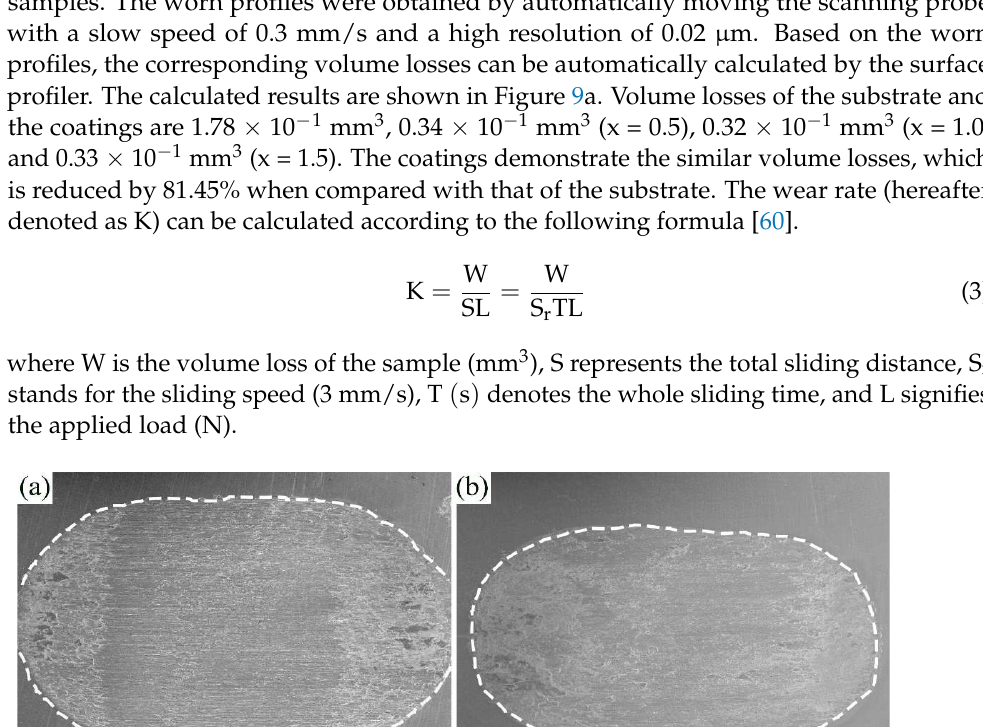
Figure 7. Coefficient of friction vs sliding time curves for the samples at room temperature under dry sliding wear test conditions.